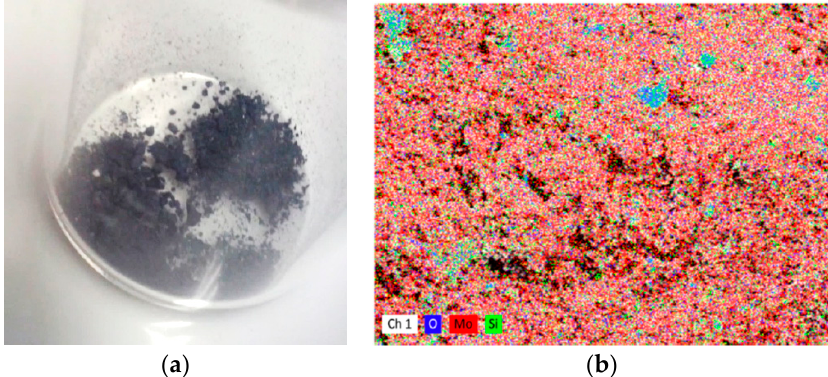
Figure 9. R-5 MoO 3 reduction product ( a ) and its energy-dispersive spectroscopy (EDS) map analysis ( b ).